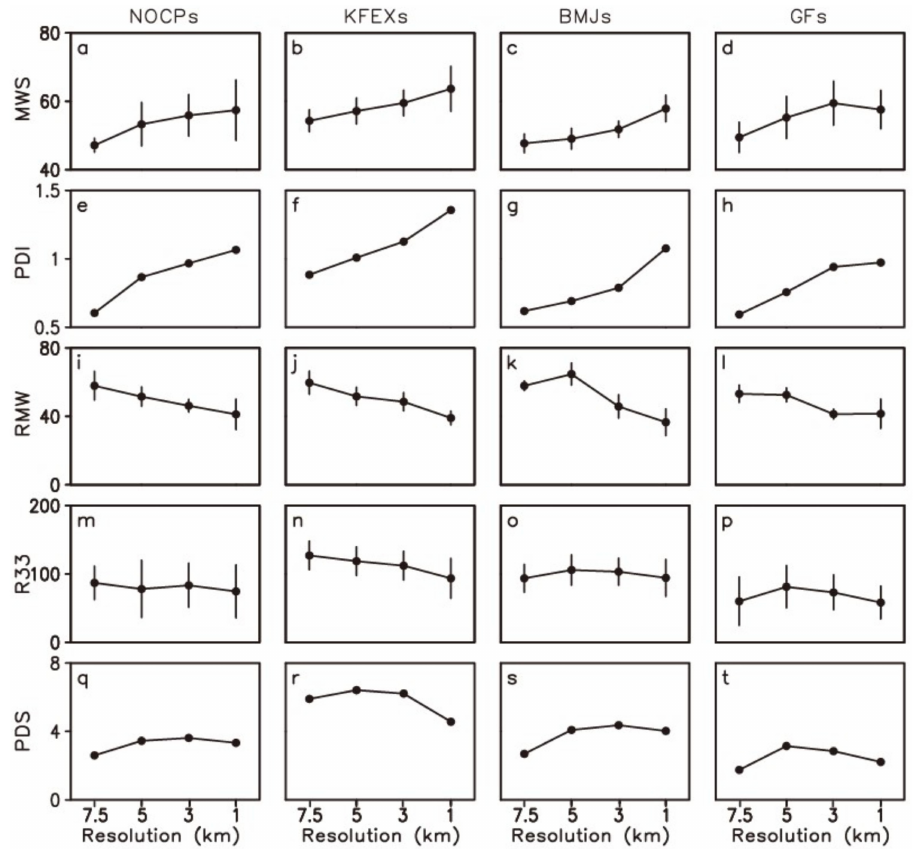
Figure 2. Changes of time-averaged ( a – d ) MWS (m s − 1 ), ( e – h ) PDI (10 16 m 3 s − 2 ), ( i – l ) RMW (km), ( m – p ) R33 (km), ( q – t ) PDS (10 14 kg m 2 s − 2 ) with resolution in the experiments using four CP schemes in the TC mature stage from 1800UTC 15 September to 0600 UTC 16 September. The